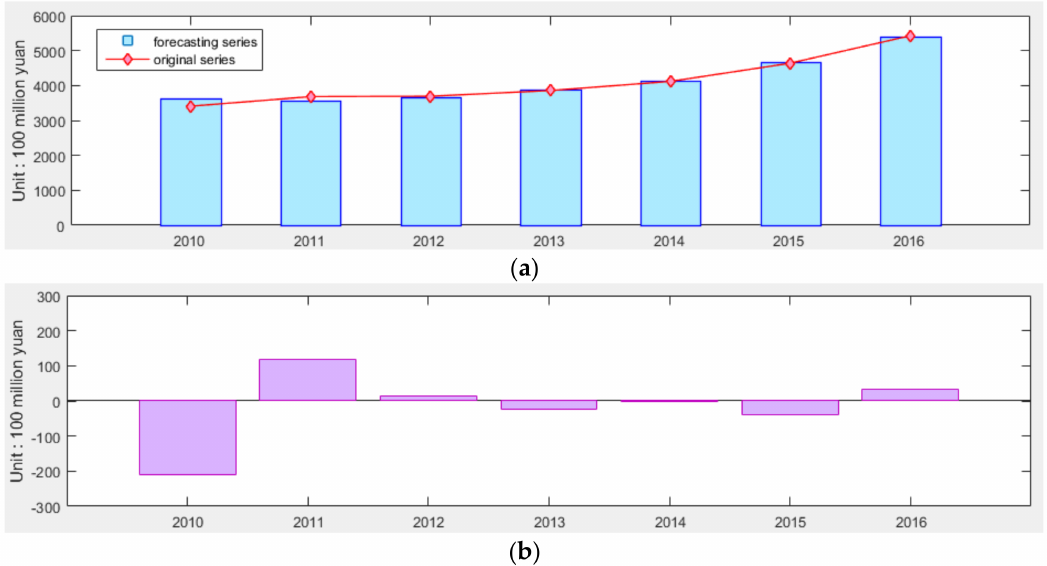
Figure 4. The prediction and residual figures. ( a ) The prediction figure; ( b ) The residual figure.